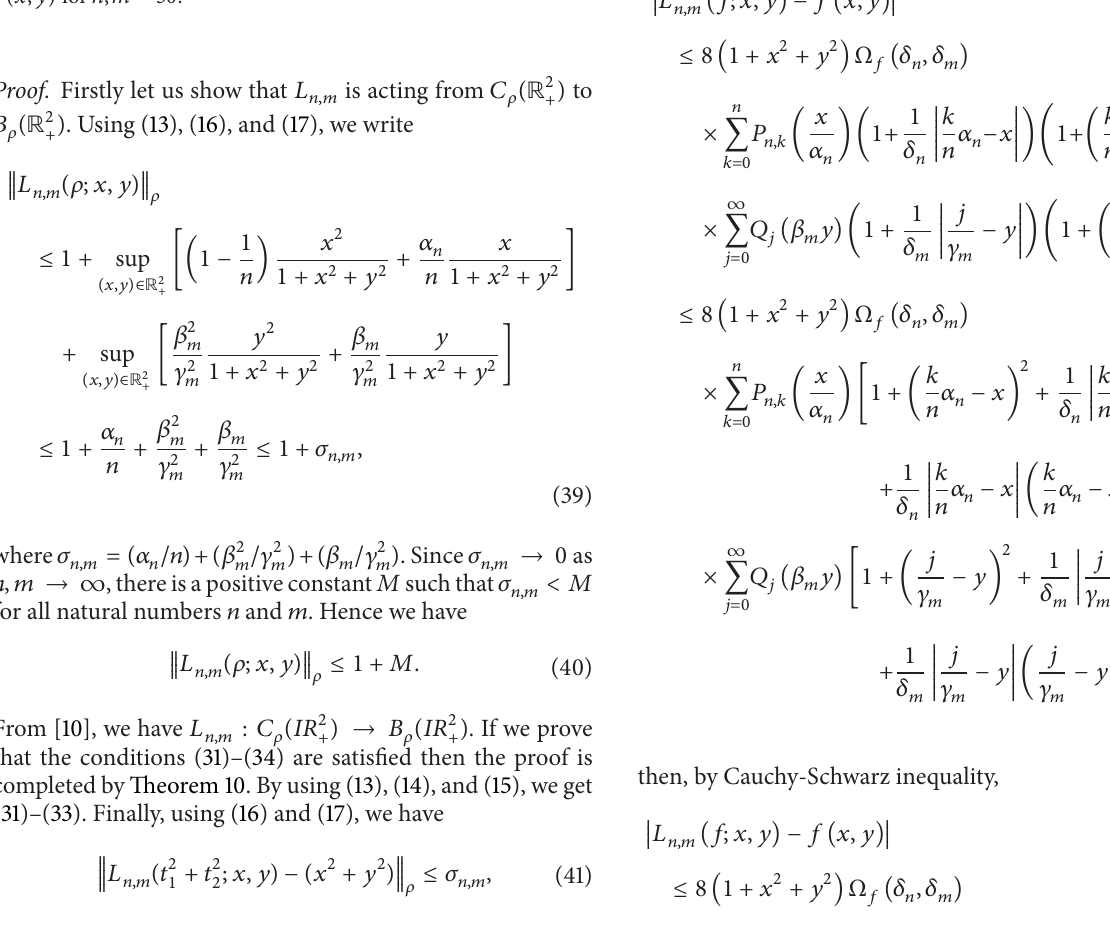
Figure 2: The convergence of 𝐿 𝑛,𝑚 (𝑓;𝑥, 𝑦) and 𝑆 𝑛,𝑚 (𝑓,𝑥,𝑦) to 𝑓(𝑥,𝑦) for 𝑛, 𝑚 = 30